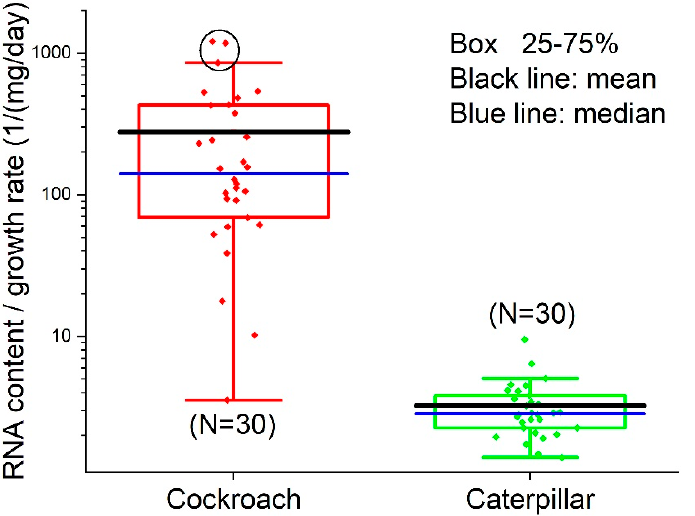
Figure 8. The RNA/growth ratio of cockroach and caterpillar midguts. Three outliers in cockroach dataset are circled. Note, the figure is in logarithm scale, so the points at the bottom of the cockroach panel are not identified by OriginLab as outliers.